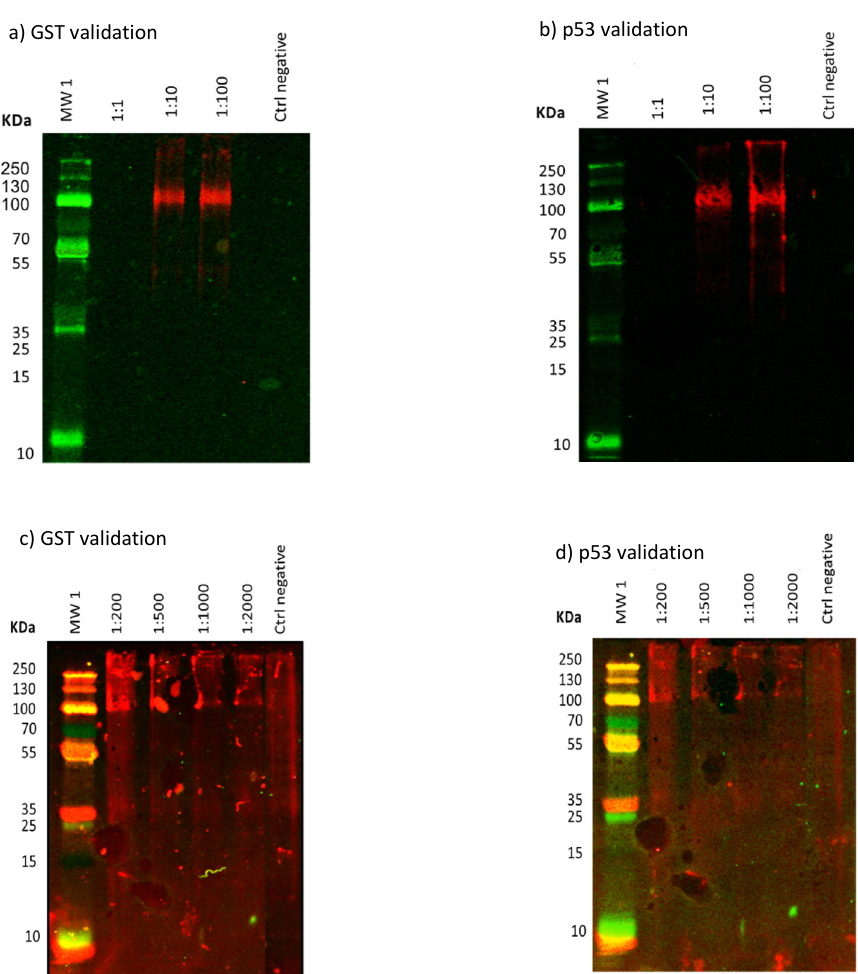
Figure 10. Detection of the GST protein label and the protein under study, p53, after expression of the recombinant protein p53-GST in an in vitro (cell-free) system in the presence of QDs-BSA- α -GST by Western Blot. (In each gel image, lane 1 corresponds to the molecular weight markers, indicating the values (KDa) in the left column; meanwhile the last lane corresponds to negative control). ( a ) Western Blot analysis of IVTT mix with cDNA 1 µg and 5 µL of IVTT reagents (dilution 1:1 at 1:100 v / v ) for the detection of GST at 480 nm. ( b ) Western Blot analysis IVTT mix with cDNA 1 µg and 5 µL of IVTT reagents (dilution 1:1 at 1:100 v / v ) for detection of p53 at 480 nm. ( c ) Western Blot analysis IVTT mix with cDNA 1 µg and 25 µL of IVTT reagents (dilution 1:200 to 1:2.000 v / v ) for the detection of GST at 680 nm. ( d ) Western Blot analysis IVTT mix with cDNA 1 µg and 25 µL of IVTT reagents (dilution 1:200 to 1:2000 v / v ) for the detection of p53 at 680 nm.